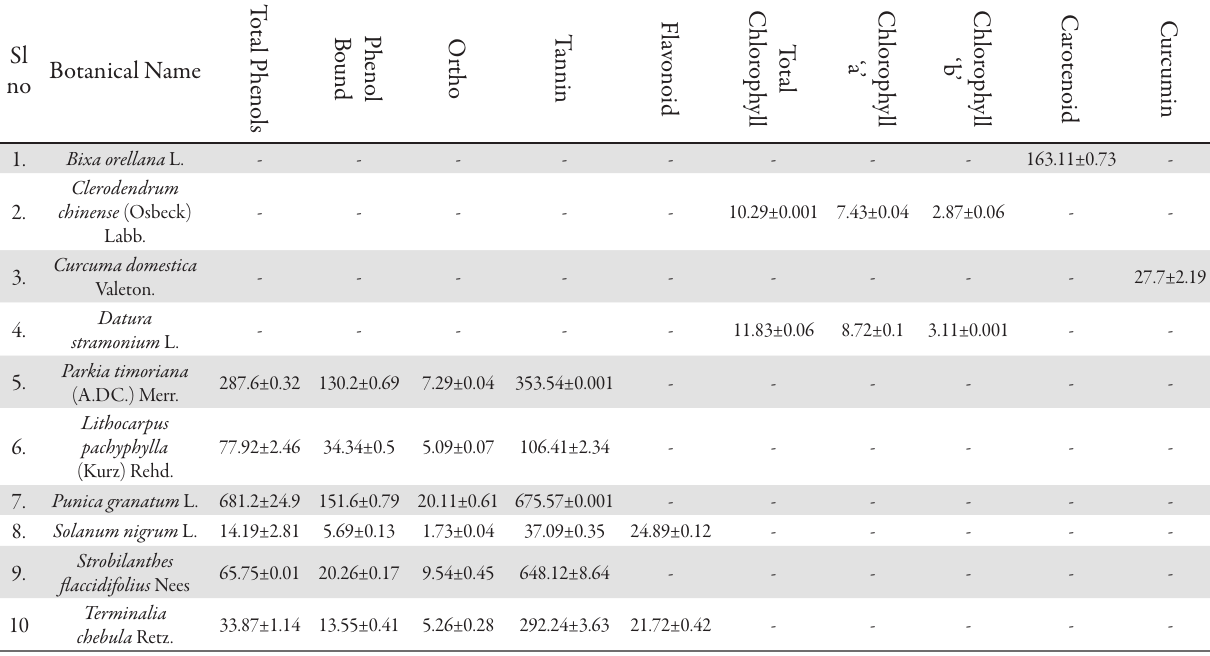
Tab. 3. Pigments responsible for dyeing in ten selected natural dye yielding plants of Manipur (mg/g) mean ± S. Em